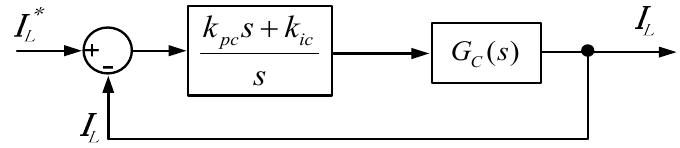
Figure 5. Current controller closed ‐ loop block diagram.